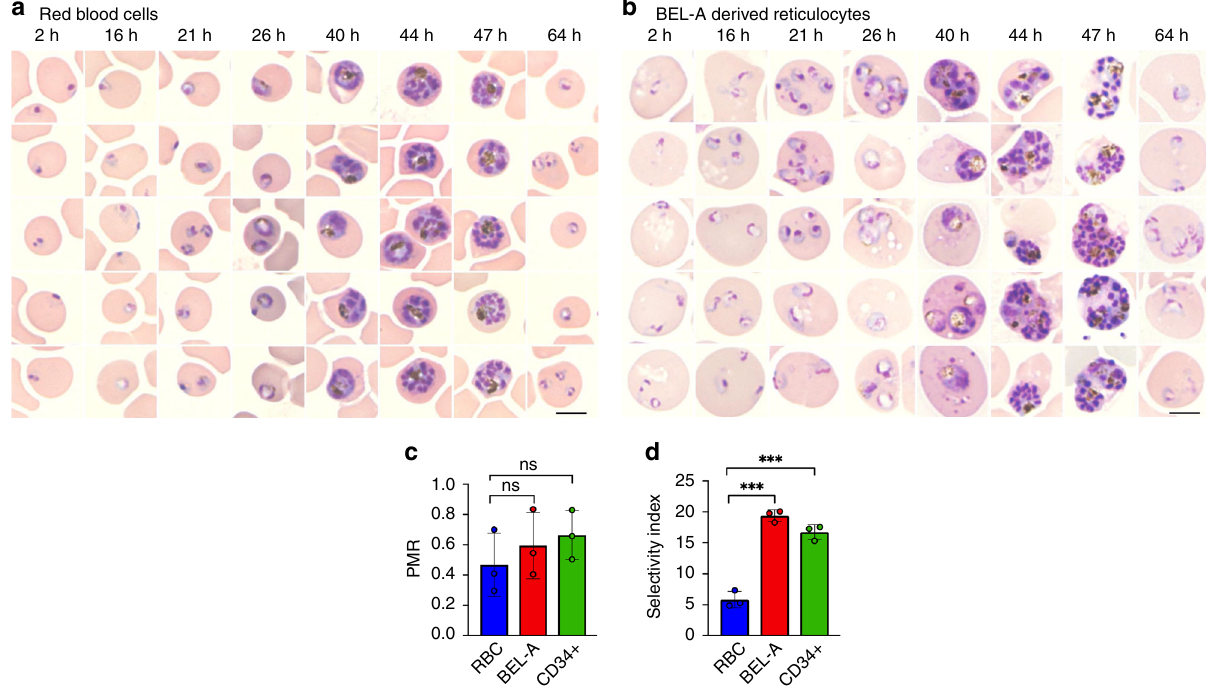
Fig. 1 BEL-A-derived reticulocytes support invasion and development of Plasmodium falciparum . a Representative images of Giemsa-stained cytospins depicting P. falciparum D10 ring stage parasites following successful invasion of donor erythrocytes or b BEL-A-derived reticulocytes at indicated timepoints illustrate development of trophozoites, schizonts at equivalent rates with appearance of new rings indicating reinvasion. Black scale bars, length 5 µ m, are shown (bottom right). c Bar graph demonstrating parasite multiplication rate (PMR), or the ratio of ring stage parasites to added mature schizonts, for BEL- A and CD34 + cell-derived reticulocytes compared with donor red blood cells. Invasion was quanti fi ed through manual counting of rings at 16 h on assessment of Giemsa-stained cytospins. d Bar graph demonstrating Selectivity Index of BEL-A and CD34 + -derived reticulocytes and red blood cells. The data shown in c – d are the mean and standard deviation of three biological replicates ( n = 3), and individual data points are represented as fi lled circles. A two-tailed t test was used to calculate p values, where *** indicates p ≤ 0.001 and ns indicates p > 0.05. Source data are provided as a Source Data fi